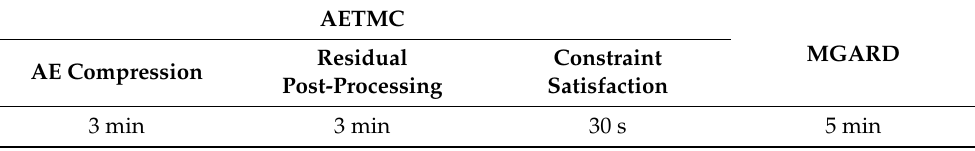
Table A3. Computation time of the AETMC framework. One set of parameters (one residual threshold and error bound) is used. For comparison, the computation time of MGARD is